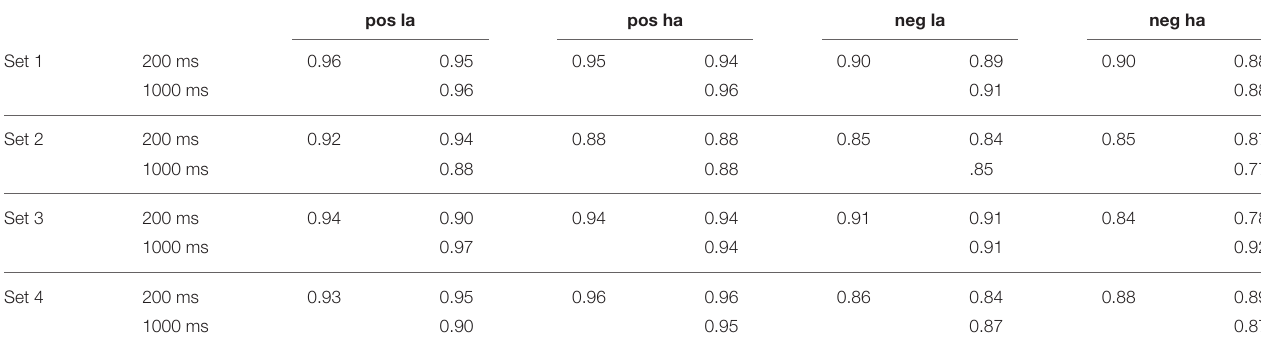
TABLE 1 | Intraclass correlation coefficients (ICC) of the valence rating procedure. pos la pos